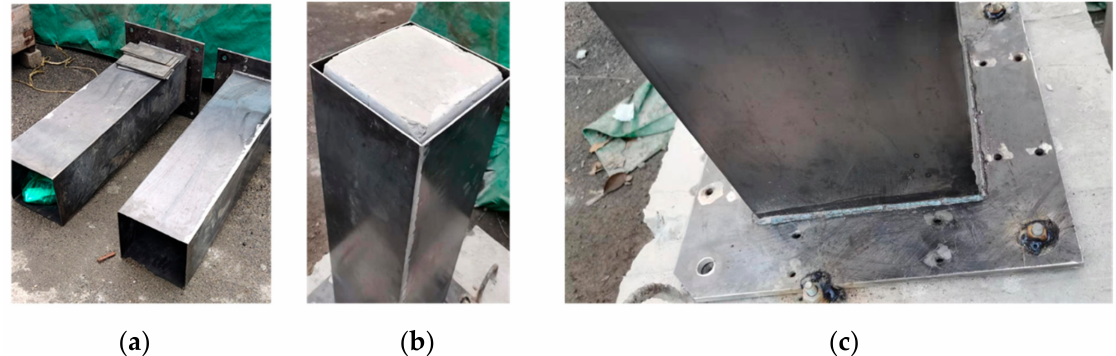
Figure 3. Processing details. ( a ) Steel tube processing ( b ) RC column inserted into the steel tube ( c ) Detail of the bottom of the steel tube.